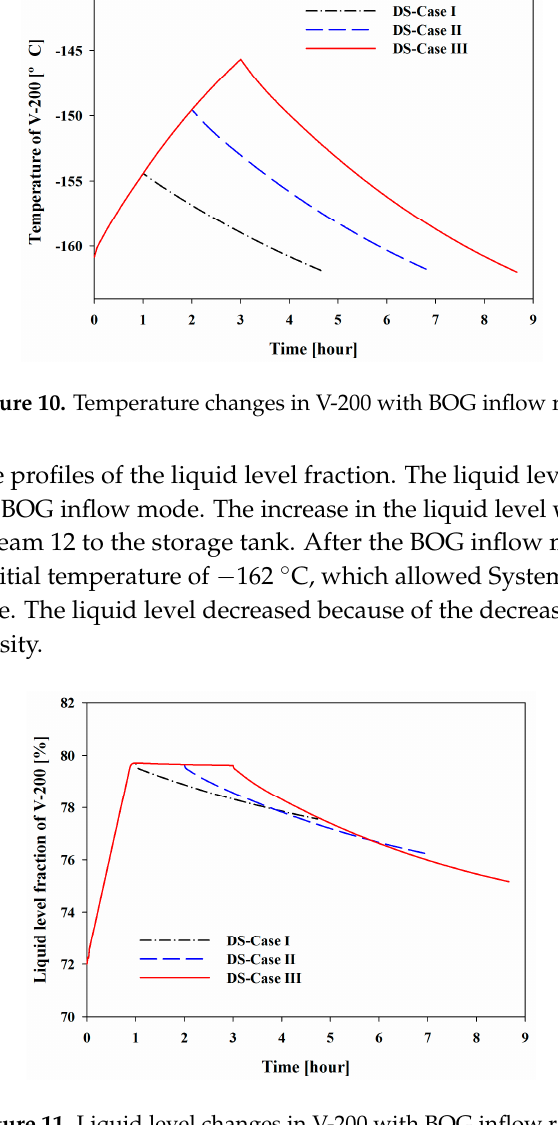
Figure 11. Liquid level changes in V-200 with BOG inflow rate.